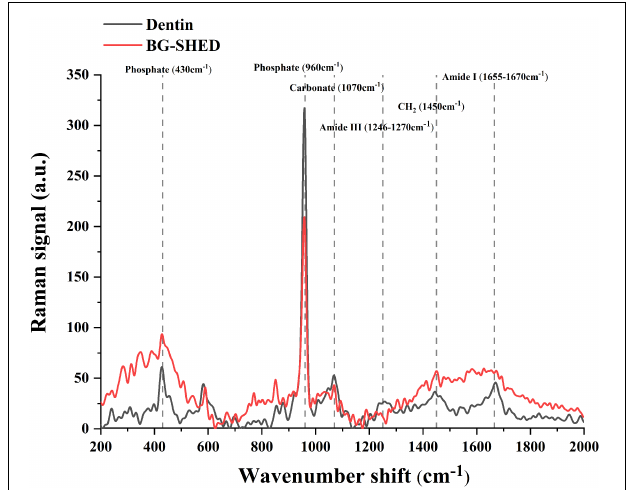
FIGURE 6 | Representative Raman spectrum of mineral components in the mineralized matrix and native dentin. The red line represents the Raman spectrum of mineralized matrix in SHEDs. The black line represents the Raman spectrum of the native dentin of deciduous teeth.